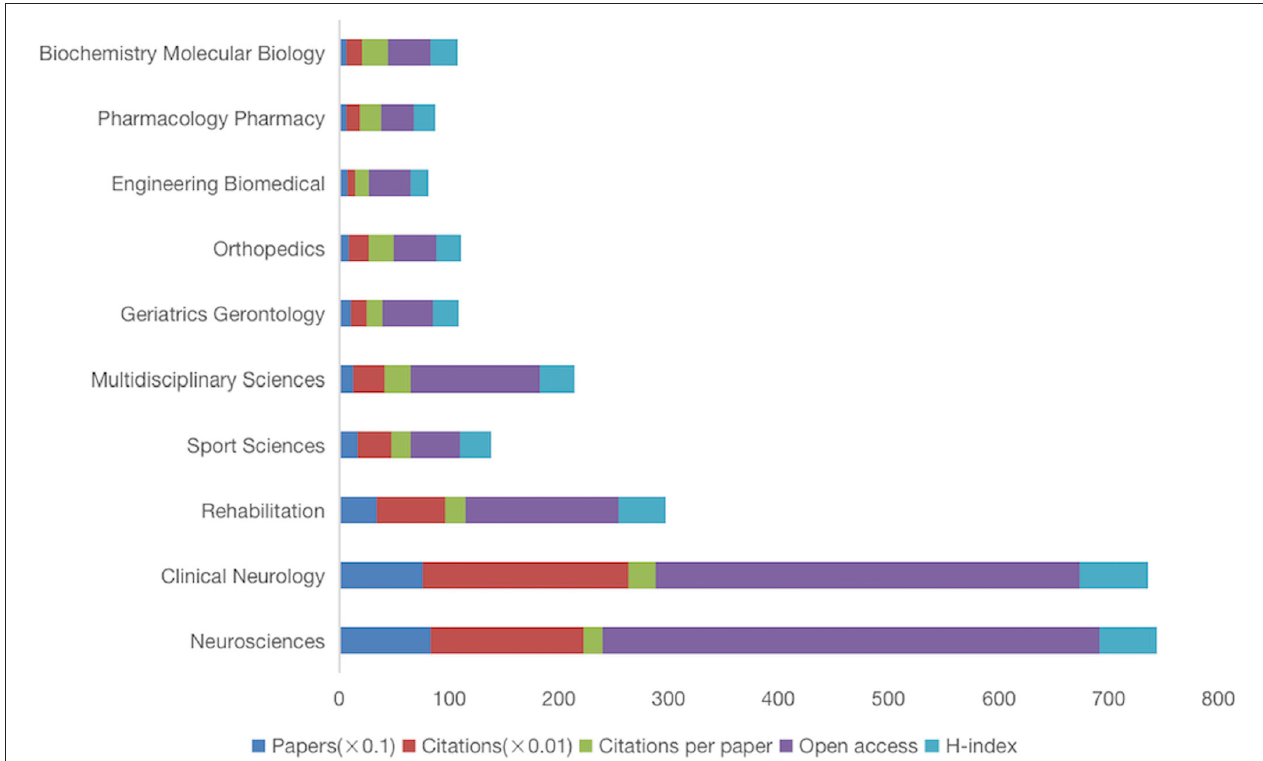
FIGURE 3 | Ranking of the top 10 disciplines related to exercise for PD.